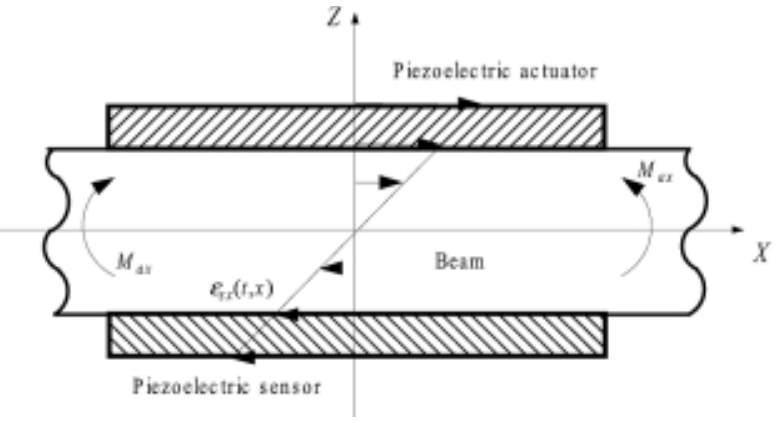
Fig. 2. Piezoelectric distributed sensor-actuator-beam configuration and associated strain